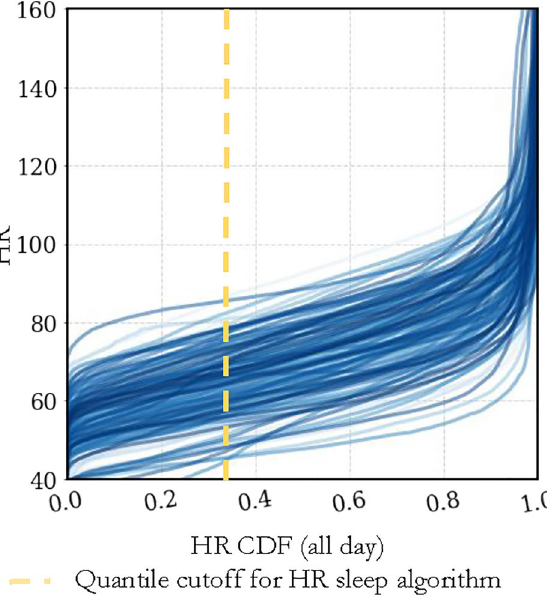
Figure 1. Cumulative distribution function for BBVS heart rates. The figure shows the HR ECDF for the full- day across all participants and all days, where the yellow dotted line shows the 0.35 HR quantile cutoff. Each individual line represents one participant for one day of